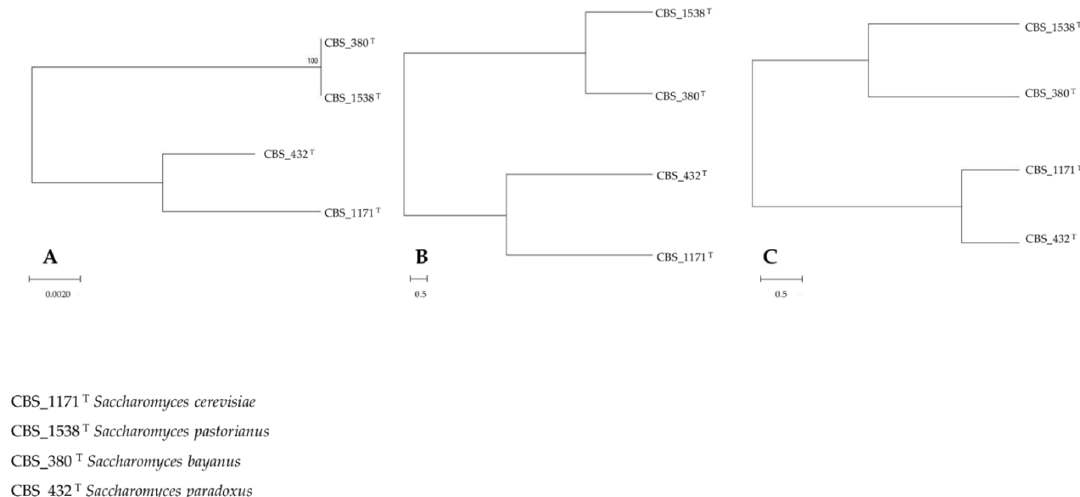
Figure 1. Genotypic vs. phenotypic FTIR and LC-MS description of S. bayanus , S. pastorianus , S. Figure1. Genotypicvs. phenotypicFTIRandLC-MSdescriptionof S.bayanus , S.pastorianus , S.paradoxus paradoxus and S. cerevisiae reference strains . Hierarchical clustering of S. bayanus CBS 380, S. pastorianus and S. cerevisiae reference strains. Hierarchical clustering of S. bayanus CBS 380, S. pastorianus CBS